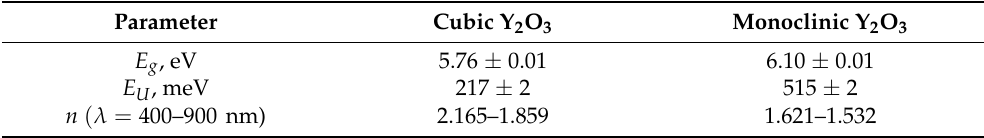
Table 1. Fundamental optical parameters of cubic and monoclinic nanocrystalline Y 2 O 3 films. E g is the optical transparency gap; E U denotes Urbach energy; n is the refractive index in the λ = 400–900 nm range. Parameters of the monoclinic Y 2 O 3 film were taken from Ref. [45].